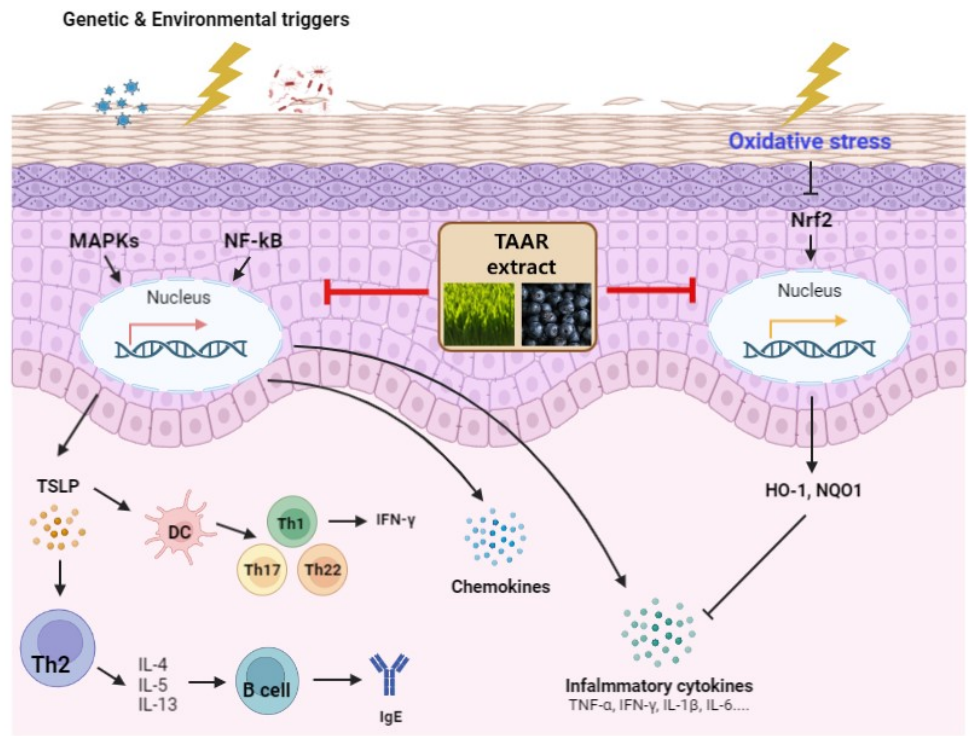
Figure 10. A pathomechanism summary of the anti-inflammatory and antioxidant effects of the TAAR extract.